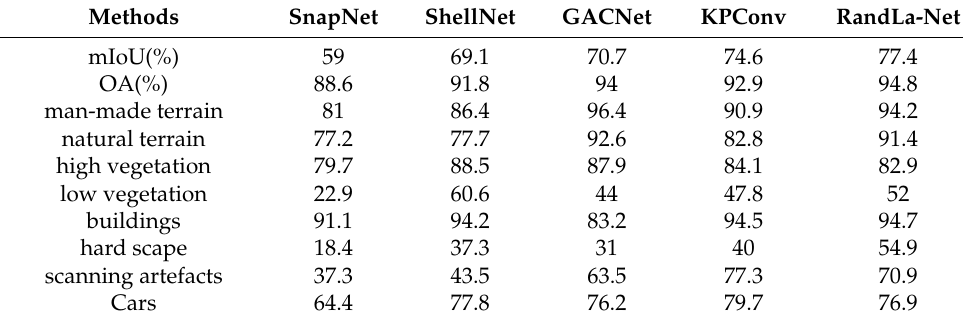
Table 2. Quantitative results of different approaches on